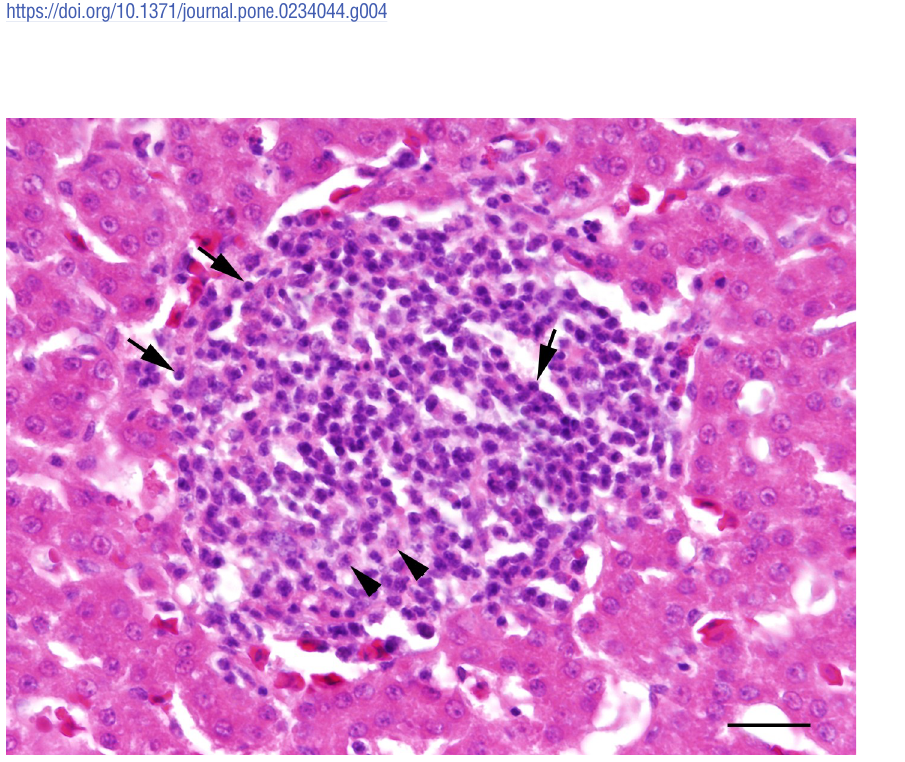
Fig 5. Pheasant chick with focal mild hepatitis characterised by infiltration of lymphocytes (arrows) and macrophages (arrowheads); HE, bar = 60 μ m.